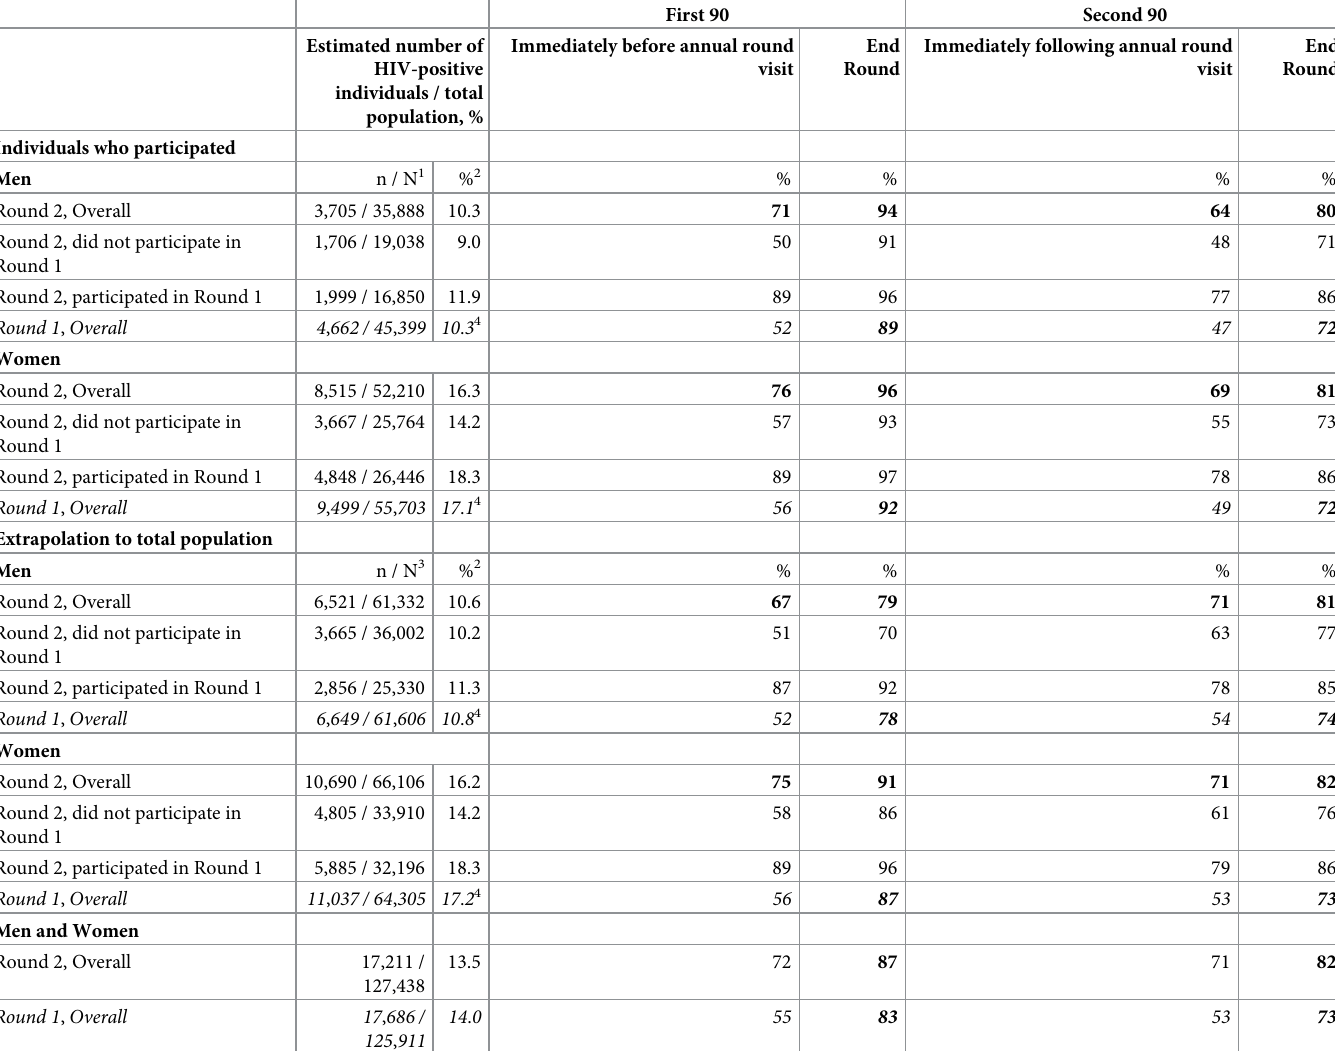
Table 3. 90–90 estimates at the start and end of Rounds 1 and 2, among individuals who participated in the intervention and with extrapolation to the total